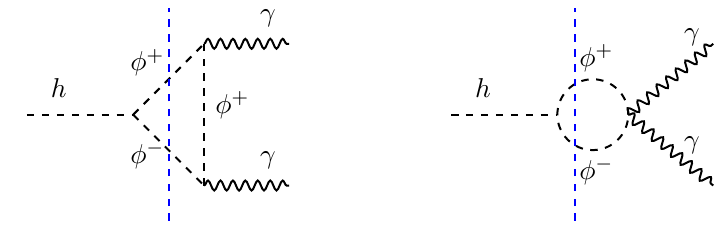
Figure 3 . Fakeon-mediated contributions to h → γγ . The blue vertical lines denote the cuts that vanish for the fakeon prescription regardless of the